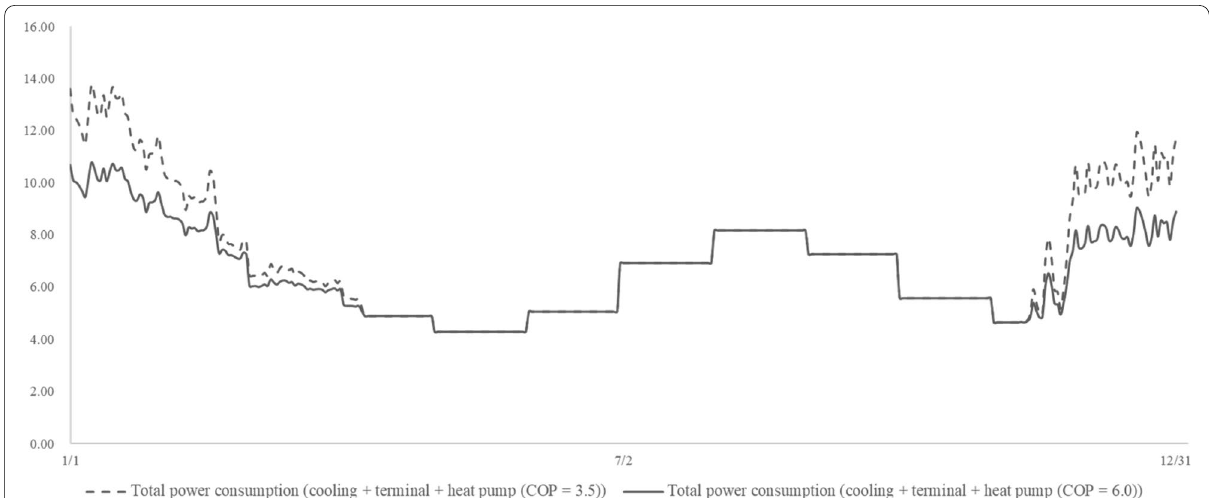
Fig. 10 Daily electricity consumption curve for the whole year of community electrification